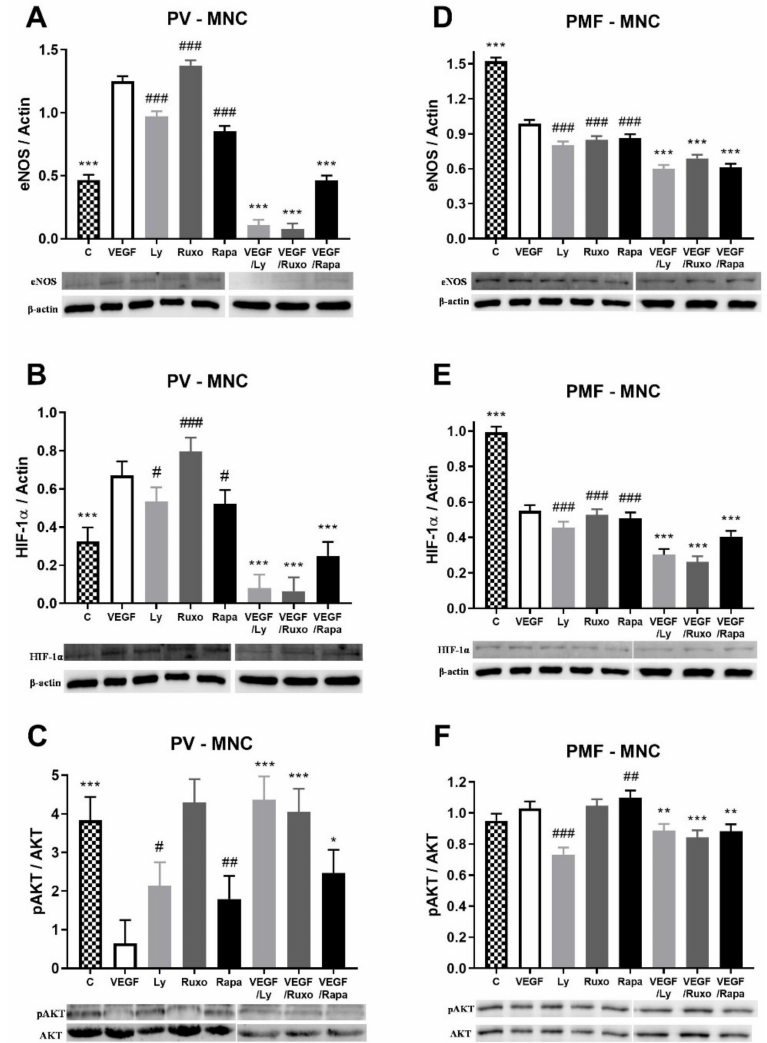
Figure 5. Vascular endothelial growth factor (VEGF) induction of angiogenic factors and related sig- nalling pathways in myeloproliferative neoplasms (MPN). Densitometry revealed protein expression determined by Western blotting and presented as a ratio to Actin of total protein levels. The MNC were treated for 1 h with 10 µ g/mL VEGF with or without 1 µ M JAK1/2 inhibitor Ruxolitinib, 5 µ M PI3K inhibitor LY294002 and 100 ng/mL mTOR inhibitor Rapamycin. The levels of ( A ) endothelial nitric oxide synthase (eNOS), ( B ) phospho AKT, and ( C ) hypoxia inducible factor 1- α (HIF-1 α ) in polycythemia vera (PV) were determined, while ( D ) eNOS, ( E ) phospho AKT, and ( F ) HIF-1 α were determined in primary myelofibrosis (PMF). Values are mean ± SEM ( n = 3). * p < 0.05, ** p < 0.01, *** p < 0.001 vs. VEGF; # p < 0.05, ## p < 0.01, ### p < 0.001 vs.